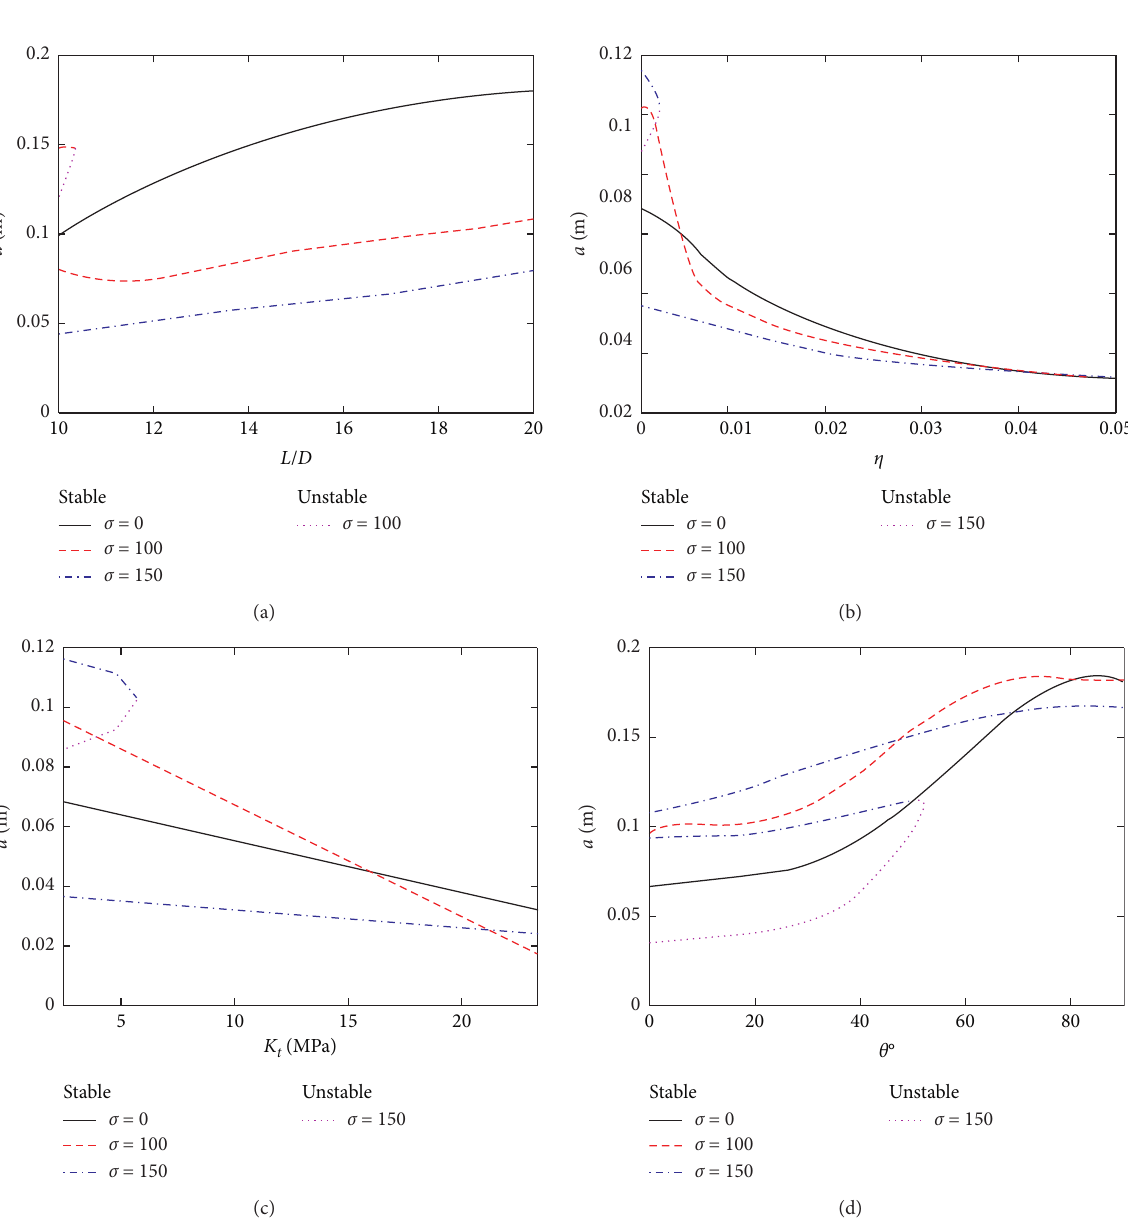
Figure 18: Trends of the amplitude as a function of the different factors at different values of the perturbation parameter: (a) Aspect ratio; (b) damping ratio; (c) cutting force coefficient; (d) ply